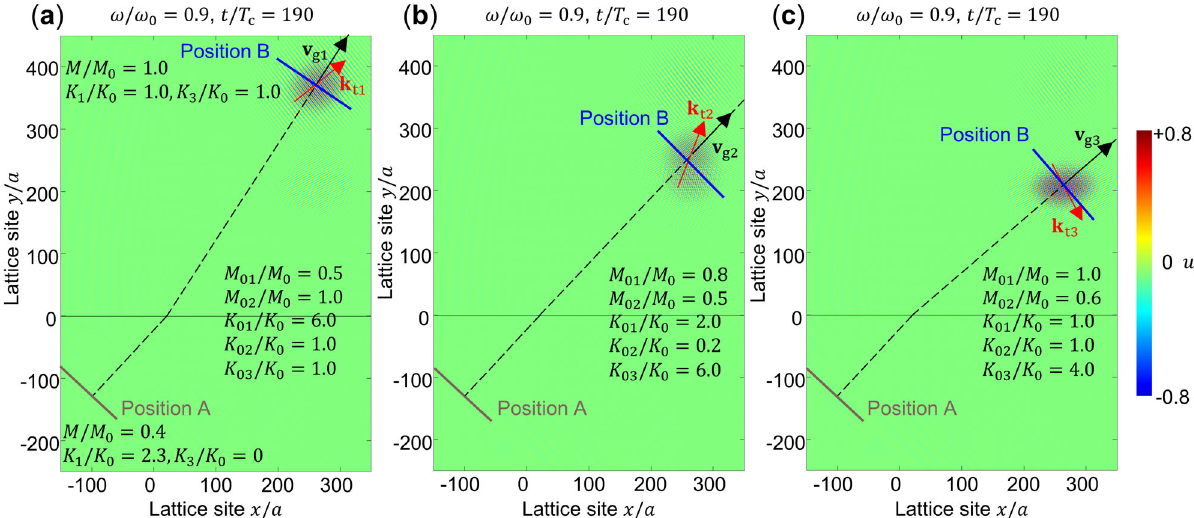
Fig. 10 Relative amplitude control of the three refracted modes at the interface between a nonlocal system and a local system by tuning the interface parameters illustrated in Fig. 7b. a Snapshot of simulated pressure fi elds with the interface parameters, M 01 = M 0 ¼ 0 : 5, M 02 = M 0 ¼ 1 : 0, K 01 = K 0 ¼ 6 : 0, K = K ¼ 1 : 0, and K = K ¼ 1 : 0, respectively. In this case, only the refracted mode with the wave vector k and group velocity vector v occurs. The 02 0 03 0 t1 g1 dashed lines indicate the propagation path of the incident and refracted waves. b , c Same as a , but with interface parameters M 01 = M 0 ¼ 0 : 8, M = M ¼ 0 : 5, K = K ¼ 2 : 0, K = K ¼ 0 : 2, K = K ¼ 6 : 0, and M = M ¼ 1 : 0, M = M ¼ 0 : 6, K = K ¼ 1 : 0, K = K ¼ 1 : 0, and K = K ¼ 4 : 0, 02 0 01 0 02 0 03 0 01 0 02 0 01 0 02 0 03 0 respectively. Animated versions of the three scenarios are provided in the Supplementary Movies 2 – 4. The displacement component u z for the cuts perpendicular to the propagation direction at the positions A (brown) and B (blue) in a – c is shown in Supplementary Fig 6. COMMUNICATIONS MATERIALS| (2022) 3:35